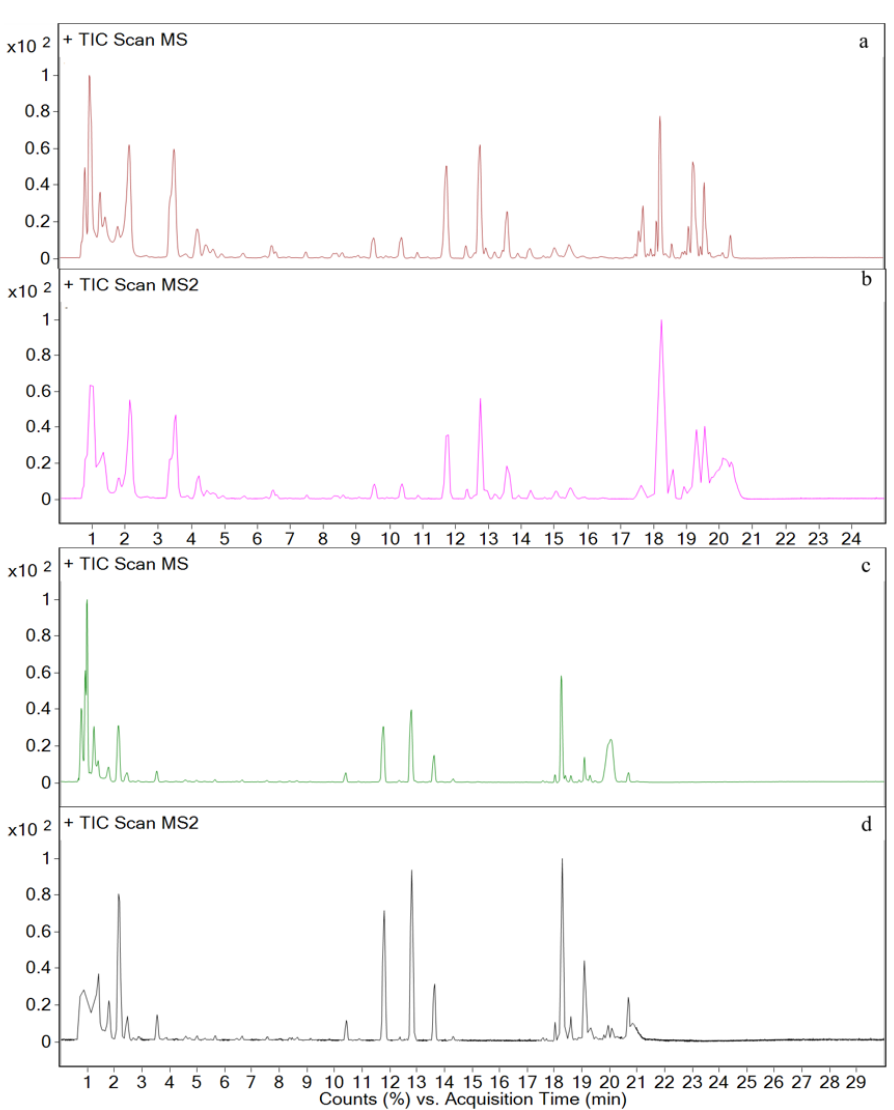
Figure A4. Total ion chromatograms of liver. ( a , b ) Blank liver; ( c , d ) Sample liver.